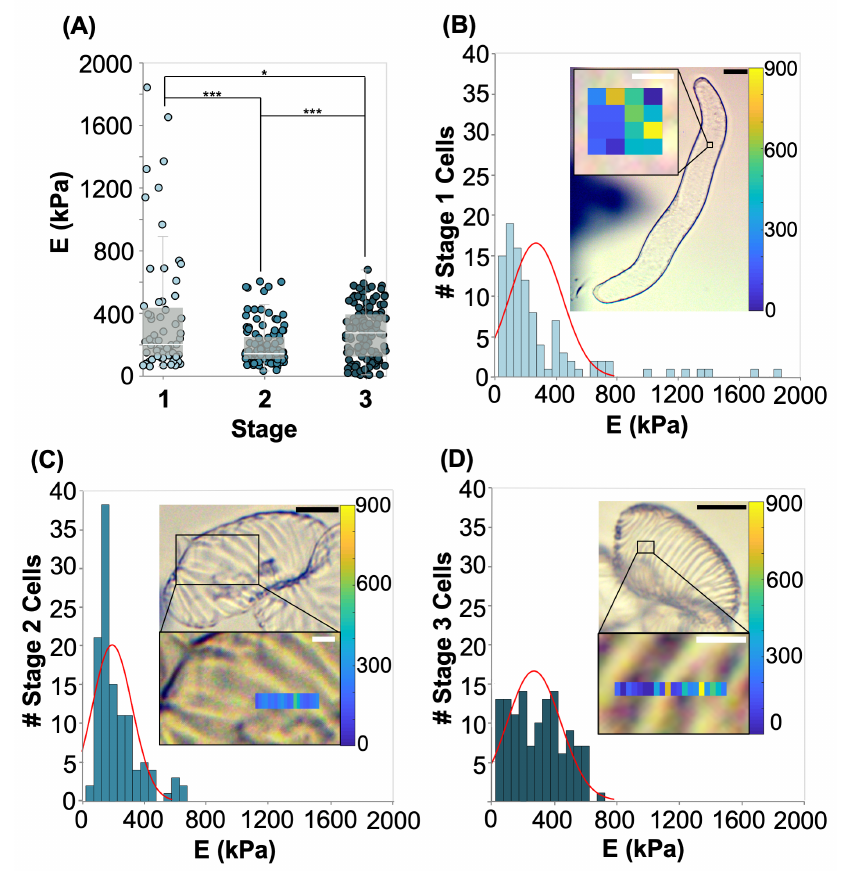
Figure 5. ( A ) Young’s modulus for differentiating VND7-inducible Arabidopsis cells in each stage of differentiation measured with AFM. Stars indicate significant differences in distribution according to a Kolmogorov-Smirnov test. * p < 0.1, *** p < 0.01. (Data shown correspond to n > 60. Each nano-indentation test is represented by a point in the plot. A minimum of 7 individual cells were tested in each stage.) ( B ) Histogram of Young’s moduli measured in stage 1 of differentiation. Inset shows example location of measurement and map of stiffness in the area. ( C ) Histogram of Young’s moduli measured in stage 2 of differentiation. Inset shows example location of measurement on cell and line map of stiffness in the area. ( D ) Histogram of Young’s moduli measured in stage 3 of differentiation. Inset shows example location of measurement on cell and line map of stiffness in the area. Inset image scale bars are 20 µ m (black). Zoomed-in inset scale bars are 2 µ m